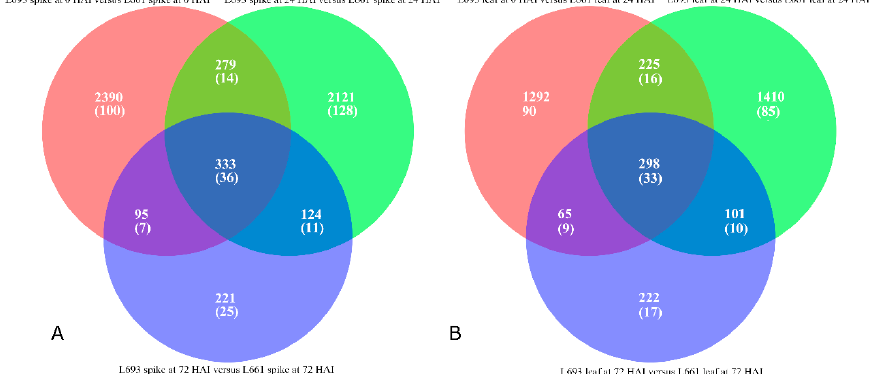
Figure 5. Venn diagram showing the number of differentially expressed genes shared by L693 and L661 at 0 h (red), 24 h (green), and 72 h (blue) after inoculation for the spike ( A ) and leaf ( B ). The numbers without parentheses represent the differentially expressed genes across the whole genome; the numbers in parentheses represent the differentially expressed genes on wheat chromosome 3B.